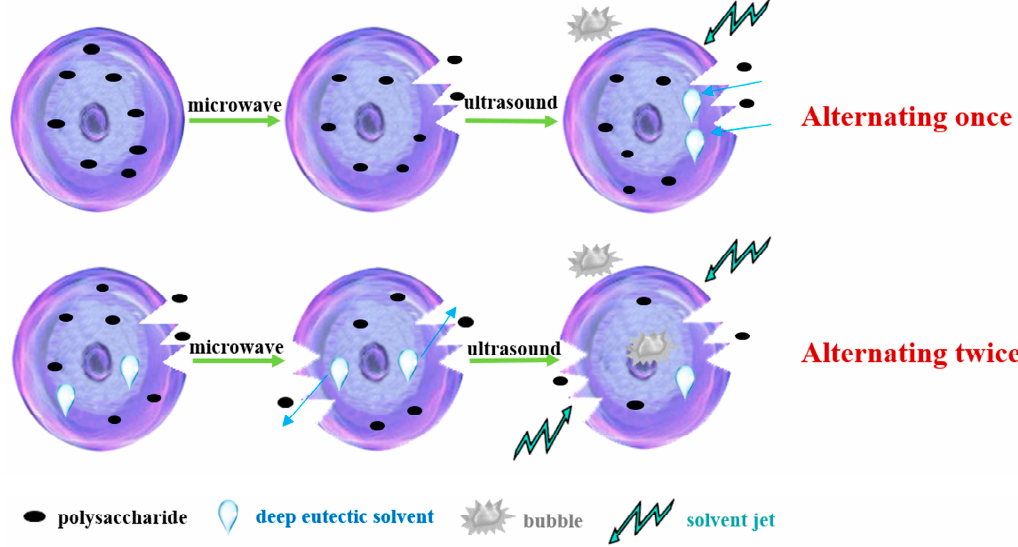
Figure 8. The mechanism of alternating ultrasound and microwave ‐ assisted extraction.